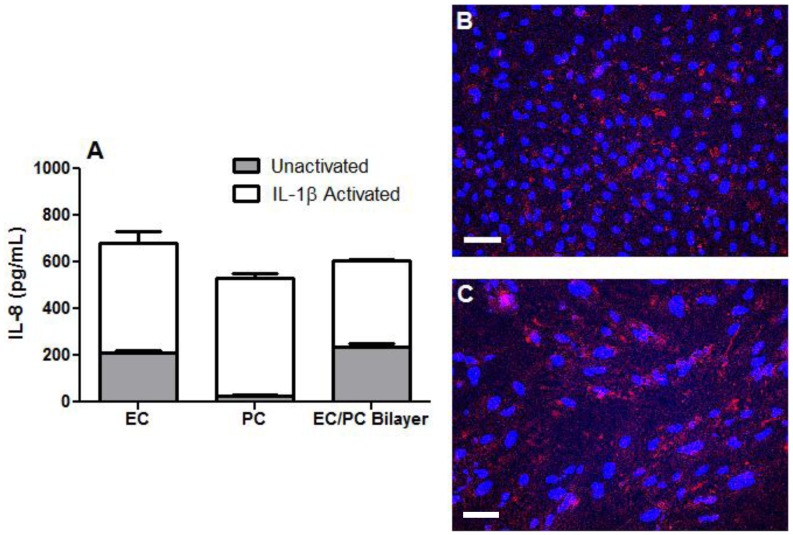
IL-8 expression and presentation.(A) EC or PC monolayers and EC/PC bilayers were grown until confluence on Transwells and incubated for 4 hr with IL-1β. Following incubation, media were removed and analyzed for IL-8 by ELISA. Bars represent average IL-8 expression ± SEM. IL-1β activated (B) EC and (C) PC monolayers were stained and imaged for cell surface bound IL-8. Bar in B and C 100 µm.